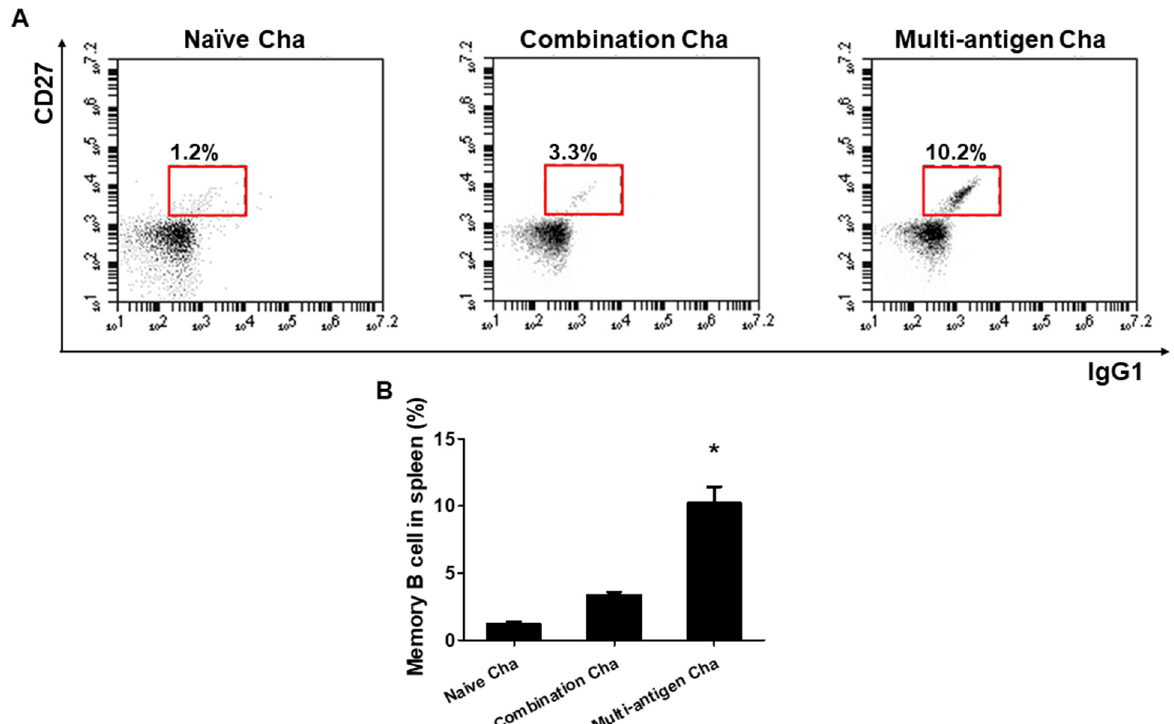
Fig 5. Memory B cell response. The memory B cells responses were determined by flow cytometry analysis. Splenocytes were stained with CD45R/B220, CD27 and IgG1 and gated with CD45R/B220 positive population. The CD45R/B220 positive cells were separated by CD27 + and IgG1 + staining as memory B cell (A). Higher level of memory B cells responses were found in multi-antigen VLPs immunized mice (Multi-antigen Cha) compared to na ï ve (Na ï ve Cha) or combination VLPs immunized mice (Combination Cha) (B, � P < 0.01).